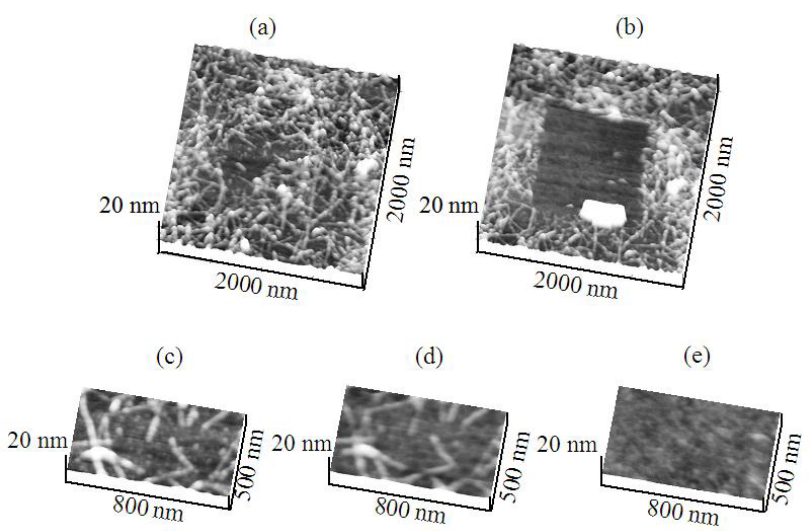
Figure 2. (a) CM-AFM topography at zero normal tip force. (b) CM-AFM topography after scanning at 106 nN normal tip force in the central 1 µm × 1 µm region. (c) , (d) ,